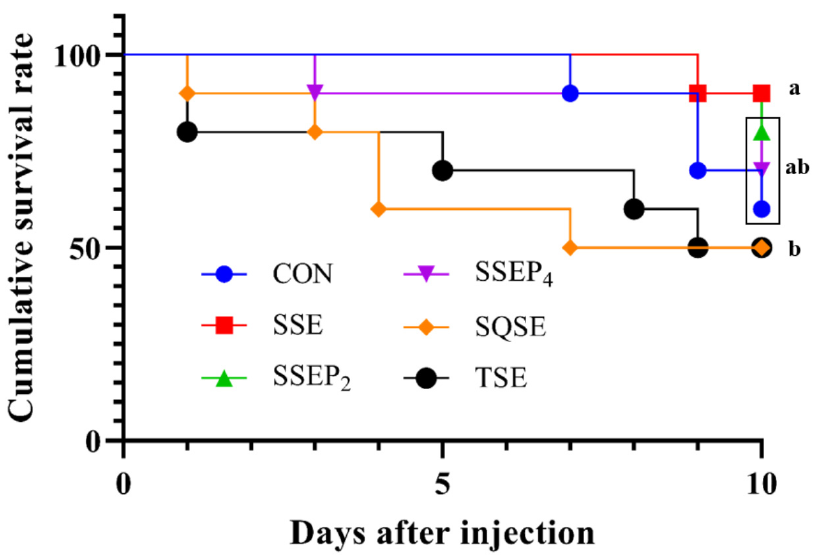
Figure 2. Cumulative survival rate of Nile tilapia fed six experimental diets in triplicate ( n = 3) and challenged with Aeromonas hydrophila (1 × 10 6 CFU/fish) for 10 days. Different letters (a,b) indicate a significant difference ( p < 0.05).